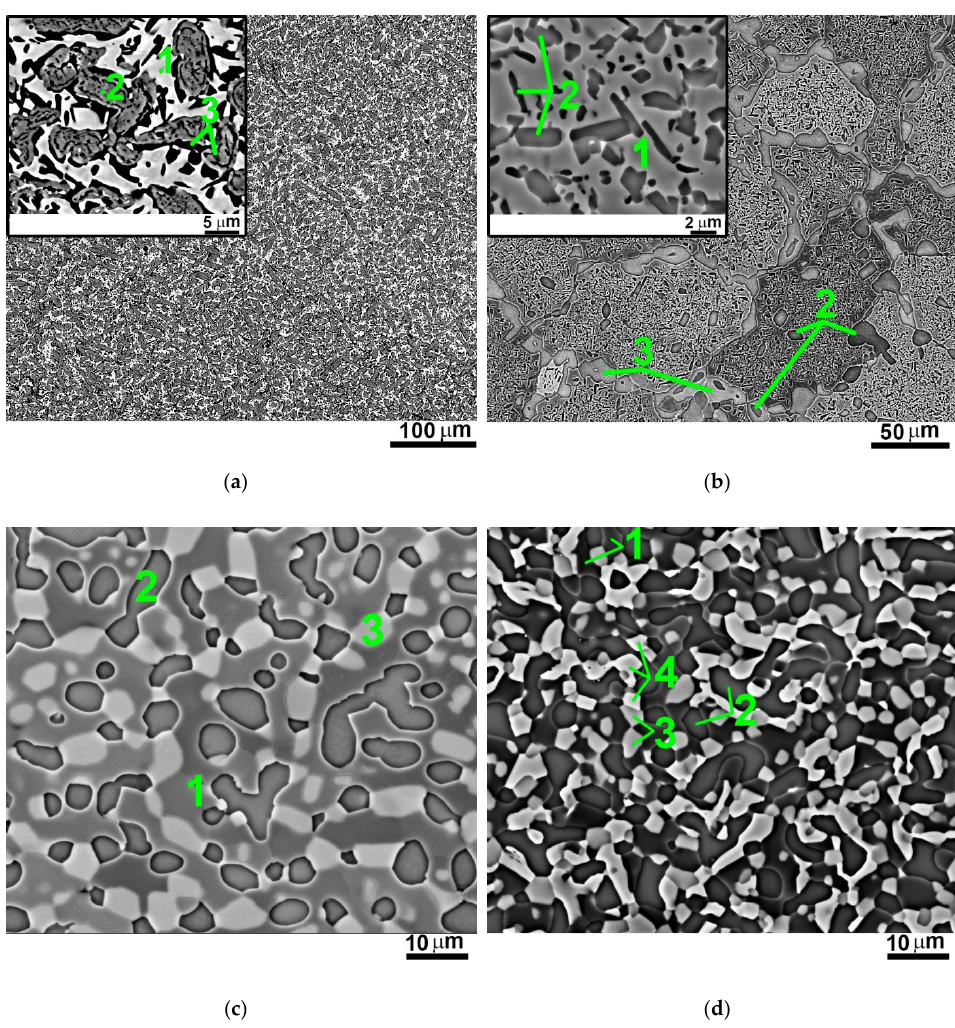
Figure 4. SEM-BSE images of the microstructures of the Al x NbTiVZr ( x = 0 ( a ); 0.5 ( b ); 1 ( c ); 1.5 ( d )) alloys after annealing at 1000 °С for 100 h. Chemical compositions and volume fractions of the numbered constituents are given in Table 2.